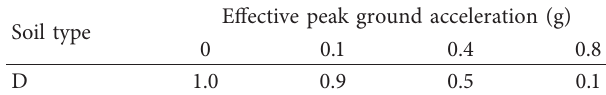
Figure 4: (a) BNWF model; (b) q-z spring behavior; (c) p-x spring behavior; (d) t-x spring behavior. Table 3: Effective shear modulus ratio ( G / G ) 0